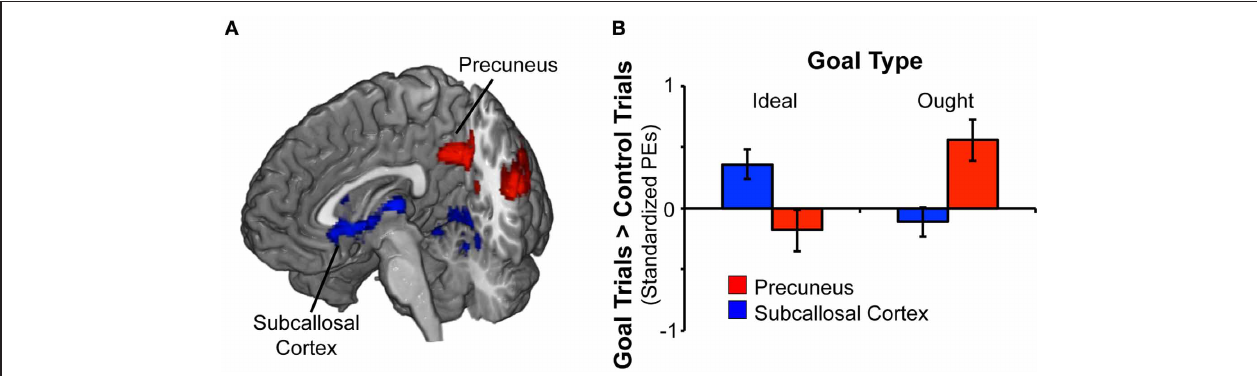
FIGURE 2 | Rapid masked promotion and prevention goal priming induced distinct patterns of activation. (A) To identify brain regions associated with activation of a promotion goal, we contrasted ideal goal priming vs. control priming. There was a significant effect for promotion goal priming in both subcallosal cortex and lingual gyrus (shown in blue). Likewise, to identify brain regions associated with activation of a prevention goal, we contrasted ought goal priming vs. control priming. There was a significant